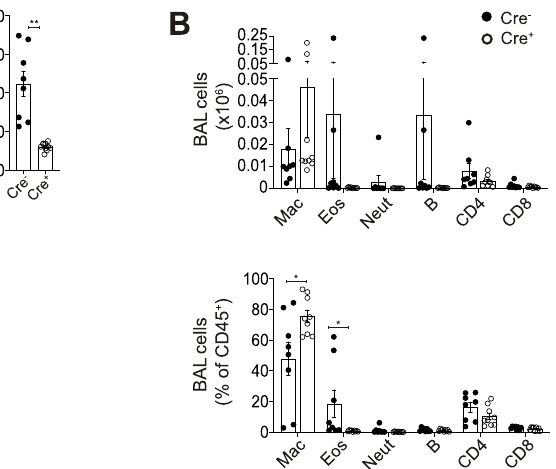
PMA/ionomycin, and cytokine production assessed via fl ow cytometry. Data are from 3 independent experiments ( n =18 biologically independent animals). Data were fi t to a linear mixed effect model, with experimental day as a random effect variable, and groups compared with a two-sided LS means Student ’ s t